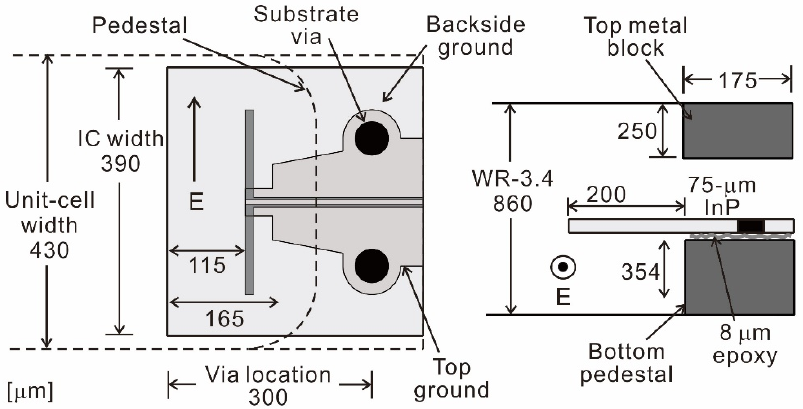
Figure 2. E- and H-plane views of the IC chip mounted in the unit cell.